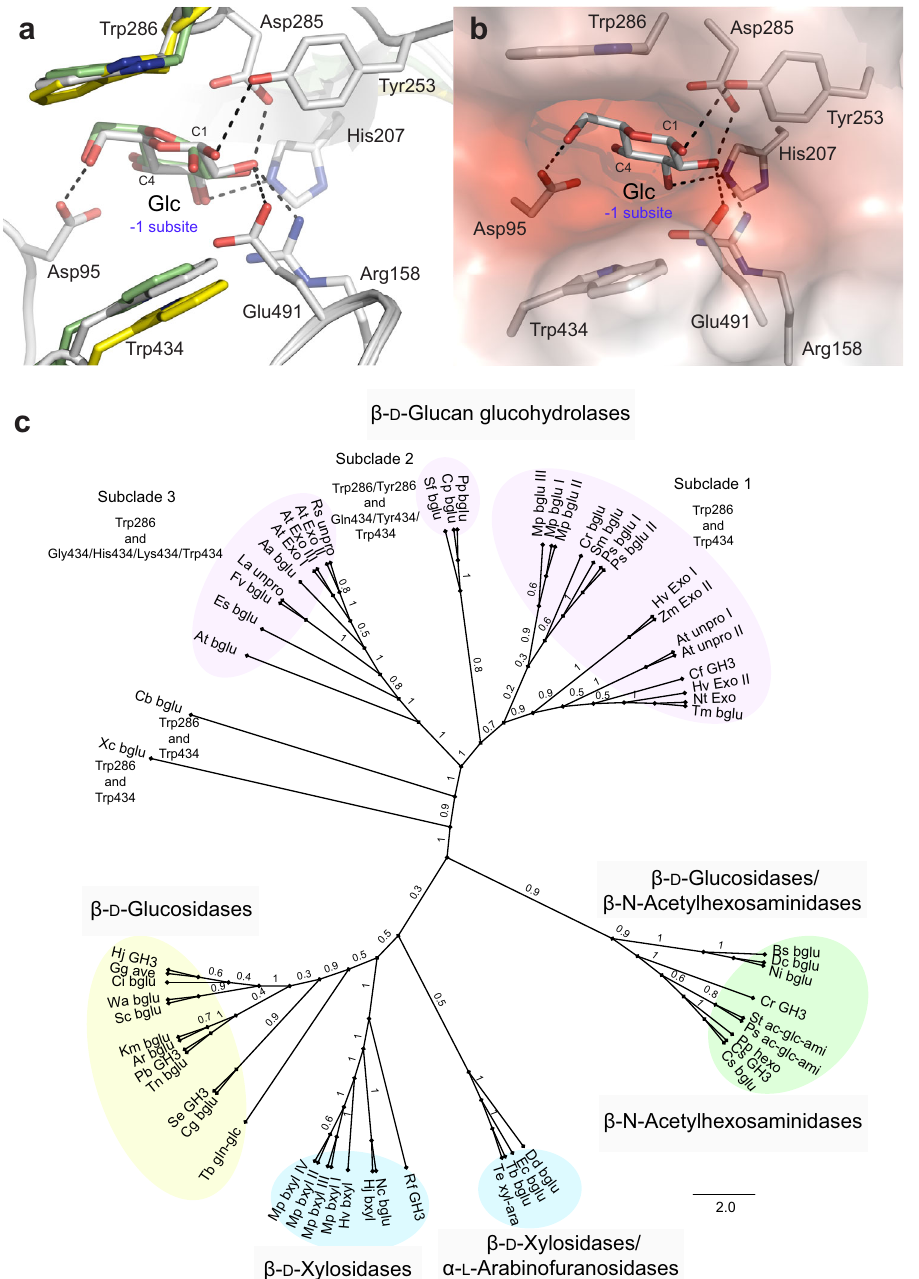
Fig. 1 | Exo-hydrolytic enzymes of the GH3 family with an entrapped Glc molecule and a ligand-free form, and their phylogeny. a Hordeum vulgare HvExoI with entrapped Glc (PDB 3WLH; atomic colours), Bacteroides ovatus β - glucosidase with perfused Glc (PDB 5JP0; green cpk), and a ligand-free form of Pseudoalteromonas sp.exo-(1,4;1,3)- β -glucanase (PDB3UT0;yellow cpk).Distances ached of HvExoI residues to Glc in the − 1 subsite (black dashes) are within 3.3Å. HvExoI and structurally equivalent residues in 3UT0 and 5JP0 superpose with respective RMSD values of 0.7Å and 1.2Å. b Surface morphology of the active site pocket of HvExoI coloured by an electrostatic potential: white, neutral; red, − 5 kT·e − 1 . Separations (dashed lines) between Glc and key interacting residues are